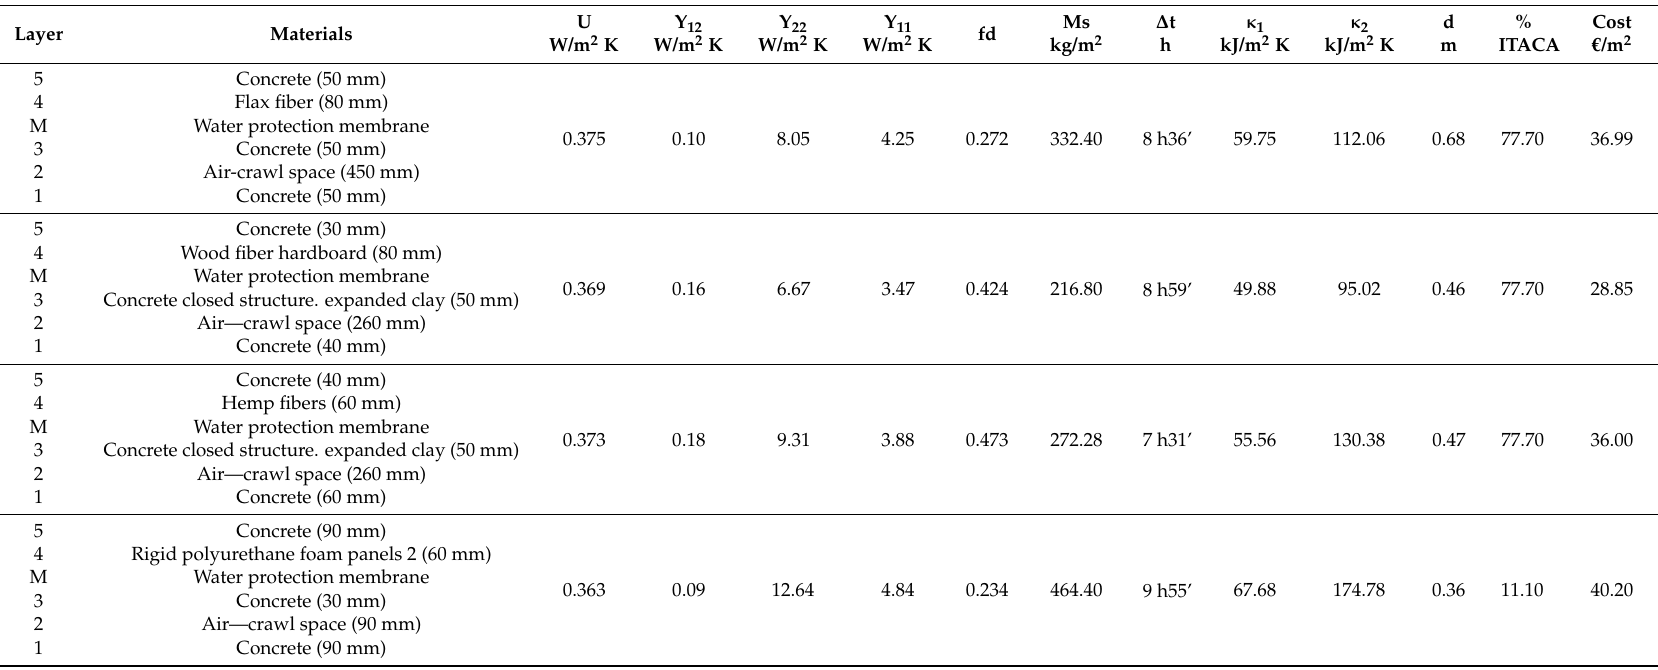
Table 11. Example of high performance slab-on-ground with crawl